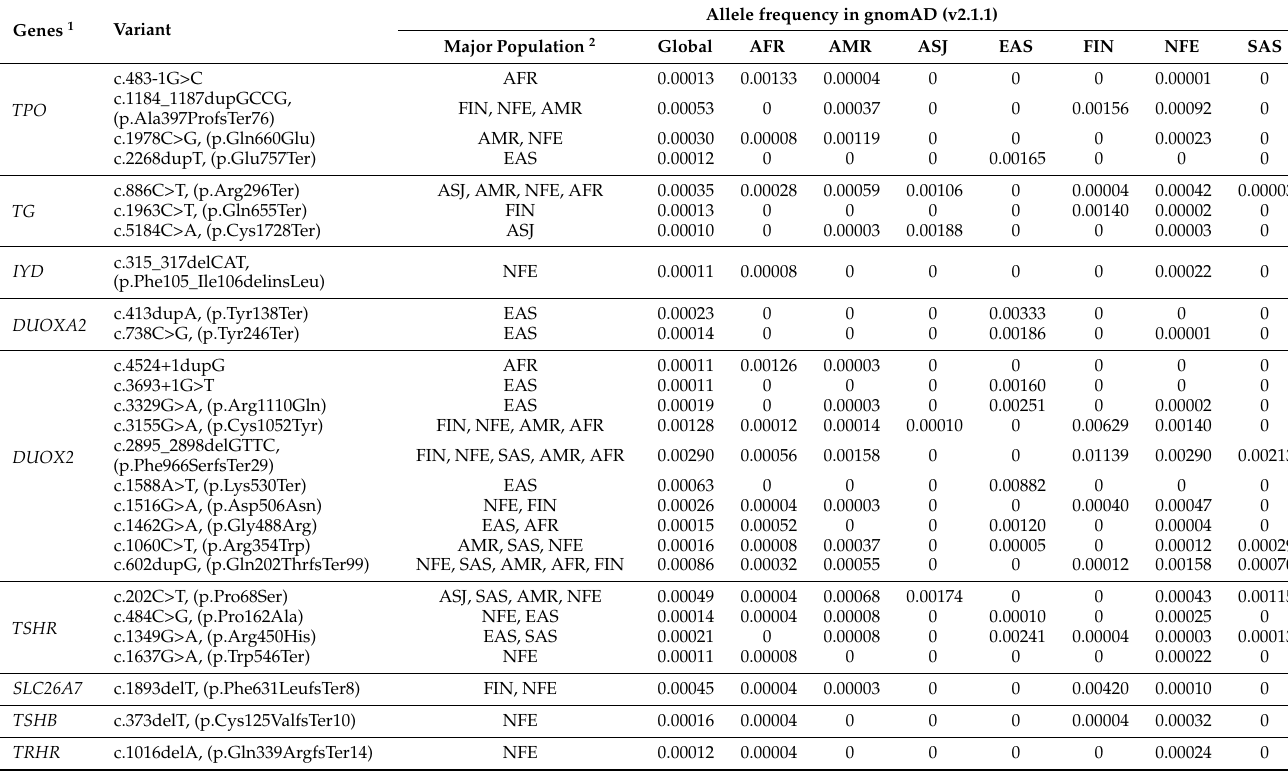
Table 2. Representative pathogenic or likely pathogenic variants with allele frequency greater than 0.0001 in global population in